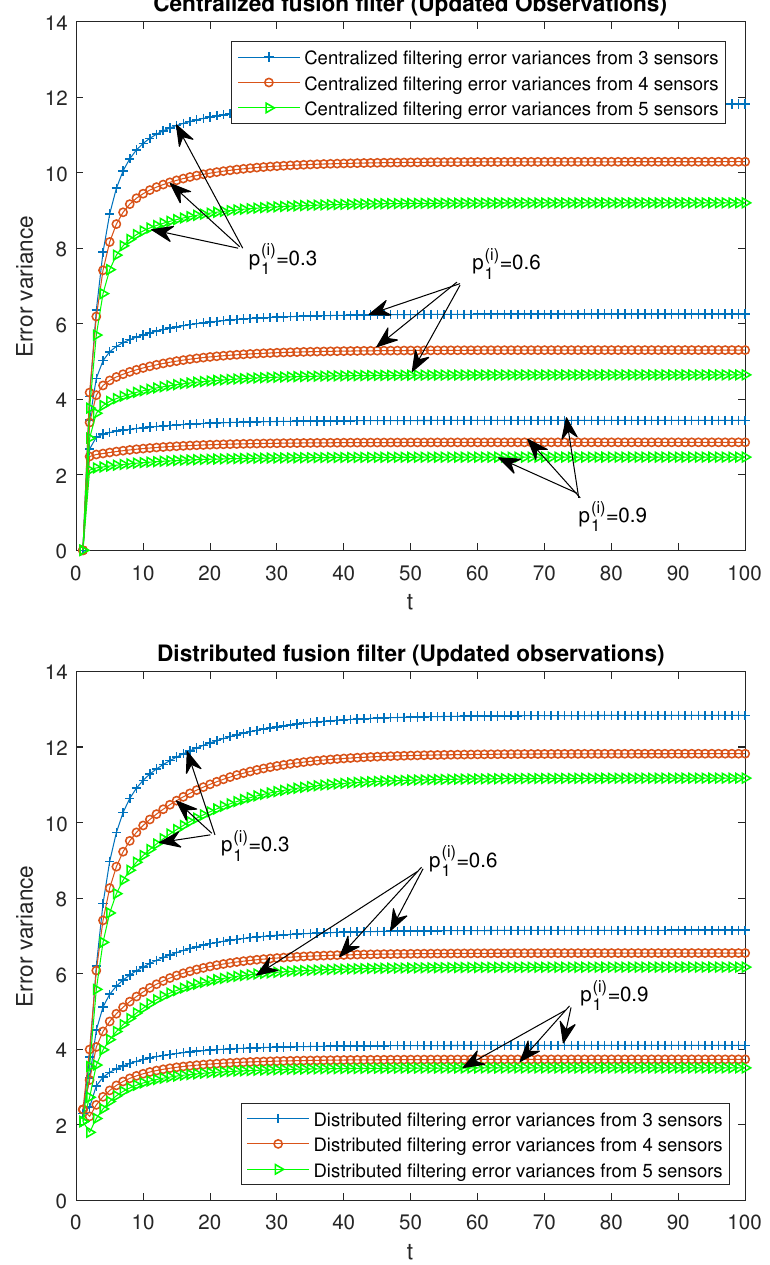
Figure 8. T 1 -proper fusion filtering error variances from updated observations with 3, 4 and 5